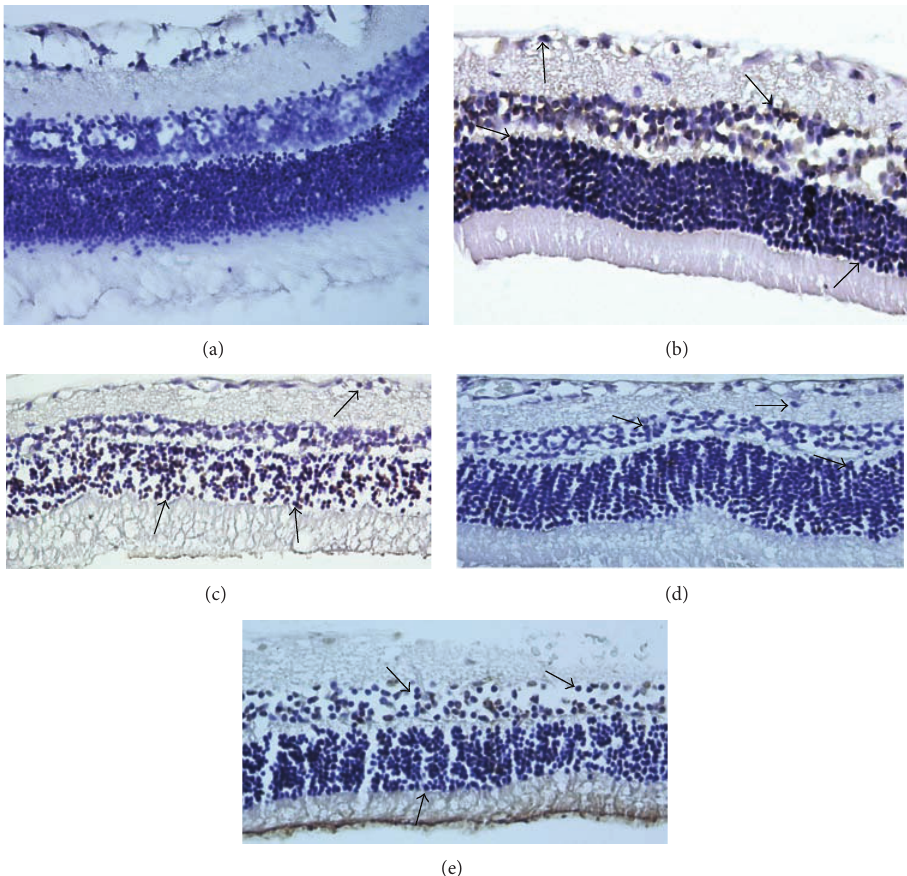
Figure 3: Tunel staining. Representative photographs of tunel staining in control (a), ischemic (b), ischemic injury plus DMSO group (c), ischemic injury treated with hesperetin group (d), and ischemic injury treated with naringenin group in rat retina (e). Positive cells of tunel staining were increased significantly in ischemic rats. However, treatment with hesperetin and naringenin markedly reduced the number of retinal cell apoptosis, respectively. Arrows: tunel-positive cells ( ×